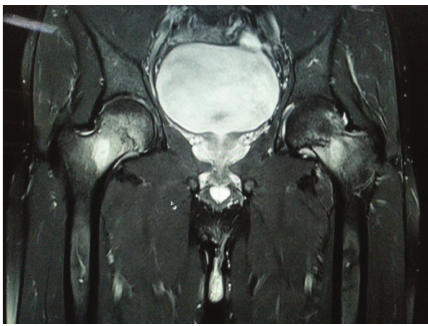
Figure 2: A T 2 weighted coronal magnetic resonance imaging (MRI) scan of pelvis with both hips showing undisplaced complete fracture on the left side and incomplete fracture on the right inferior neck.